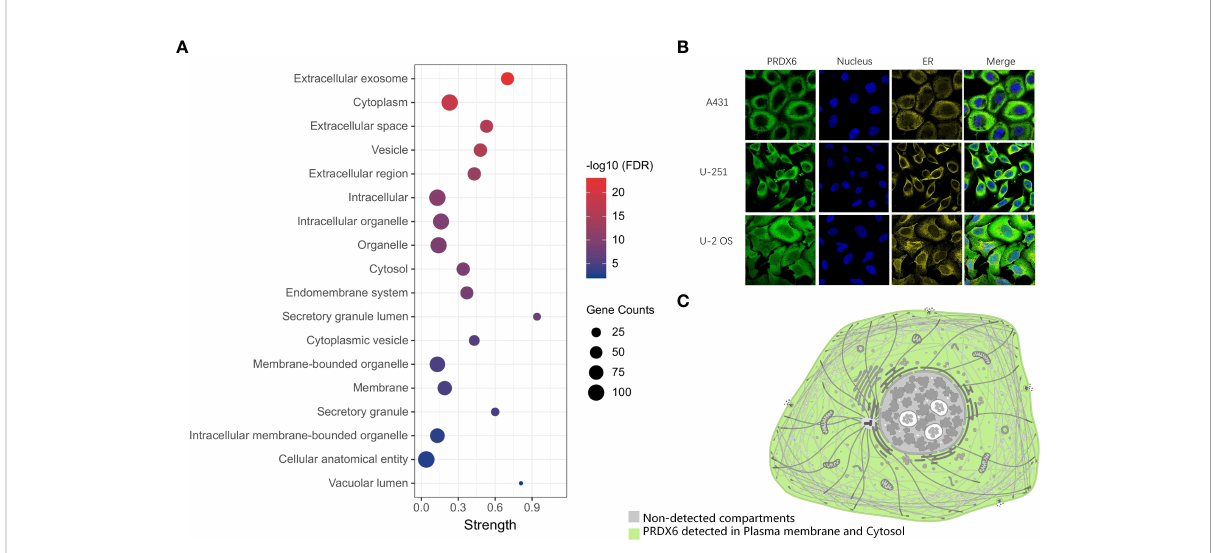
FIGURE 3 The distribution of PRDX6 in cellular components. (A) The GO functional categories of DRG proteins and ZDHHCs were performed by STRING. The CC terms including PRDX6 were selected and visualized in the bubble plot. (B) The Immuno fl uorescence results of PRDX6 in human cell lines indicate PRDX6 localizes in the plasma membrane and cytoplasm. (C) The schematic of PRDX6 subcellular localization. GO, Gene Ontology; CC, Cellular Component. A-431, Epidermoid carcinoma cell line; U-2OS, Osteosarcoma cell line; U-251 MG, Glioblastoma cell